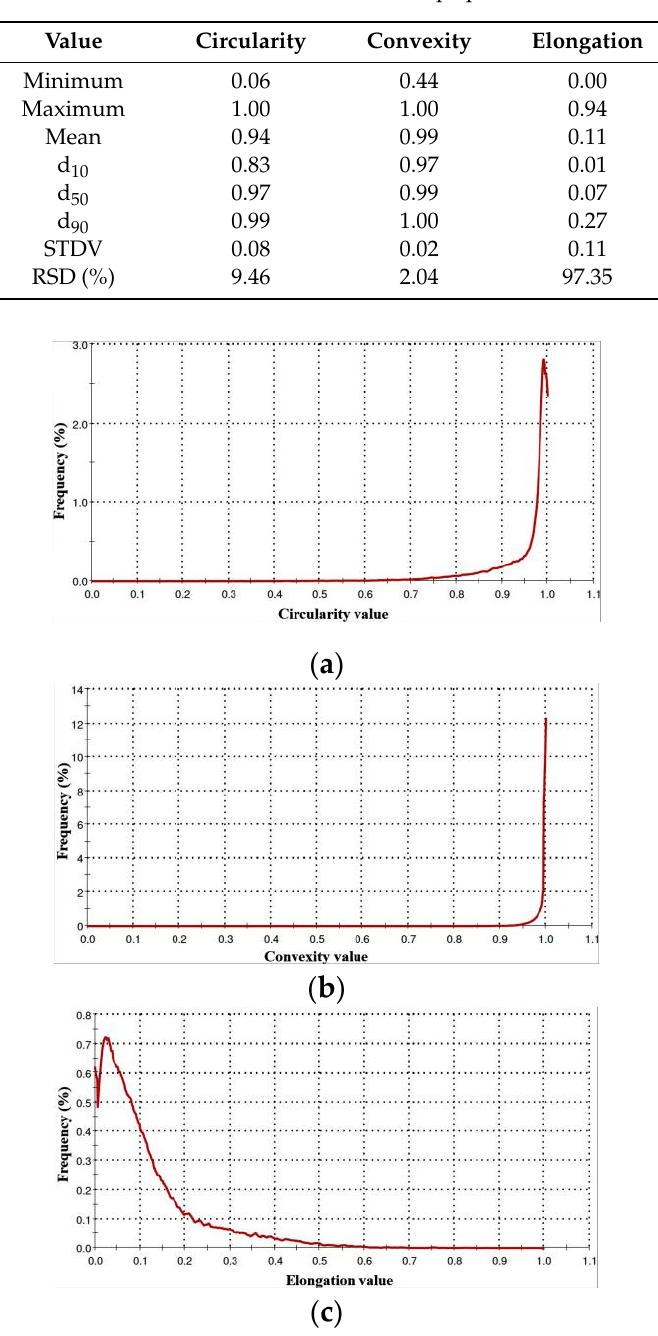
Figure 7. Particle shape charts: ( a ) Circularity; ( b ) Convexity; ( c ) Elongation. Table 3. Powder examination via shape parameters.